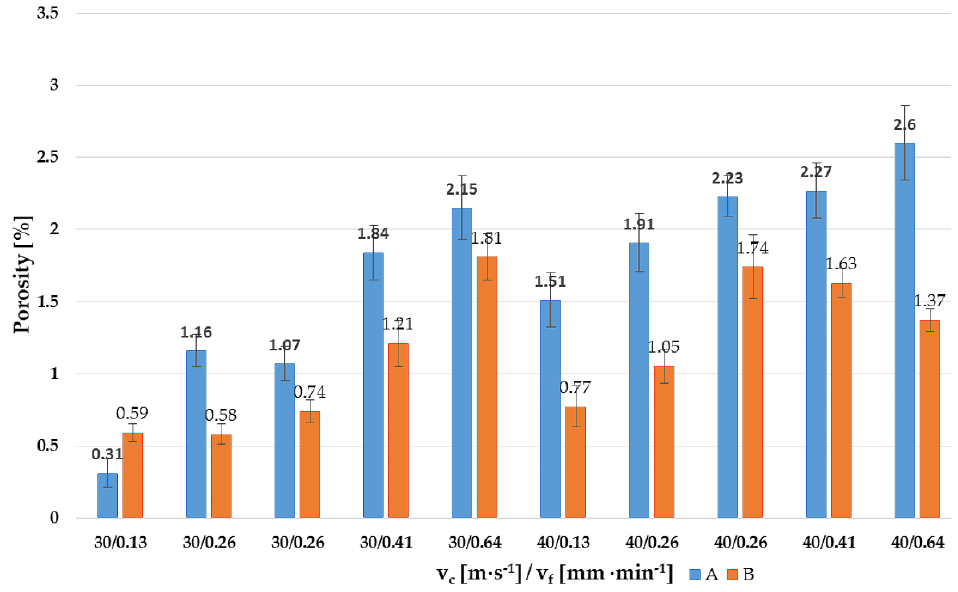
Figure 4. The porosity in grounded samples (A1 to A10, SG; B1 to B10, SiC).